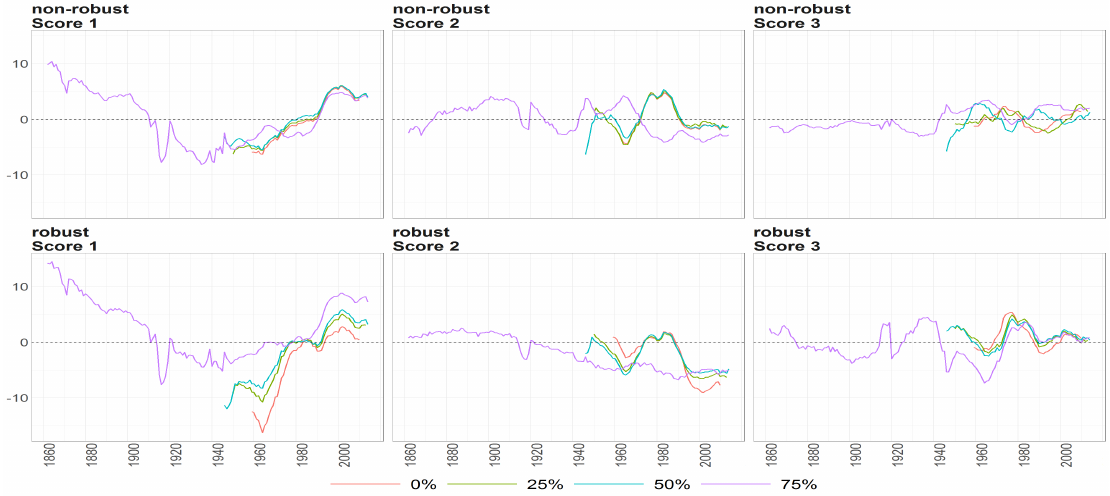
Figure 10. The scores (y axis) over time (x axis) obtained using PPCA for Females in Births. Colours of lines correspond to the scores calculated on subsample different cases of missing values (0%, 25%, 50% and 75%, refer to legend). The plots placed in the first row correspond to the results using non- robust standardization of entry data, where the second row correspond to robust standardisation. The plots scores, first, second and thirds are ordered by